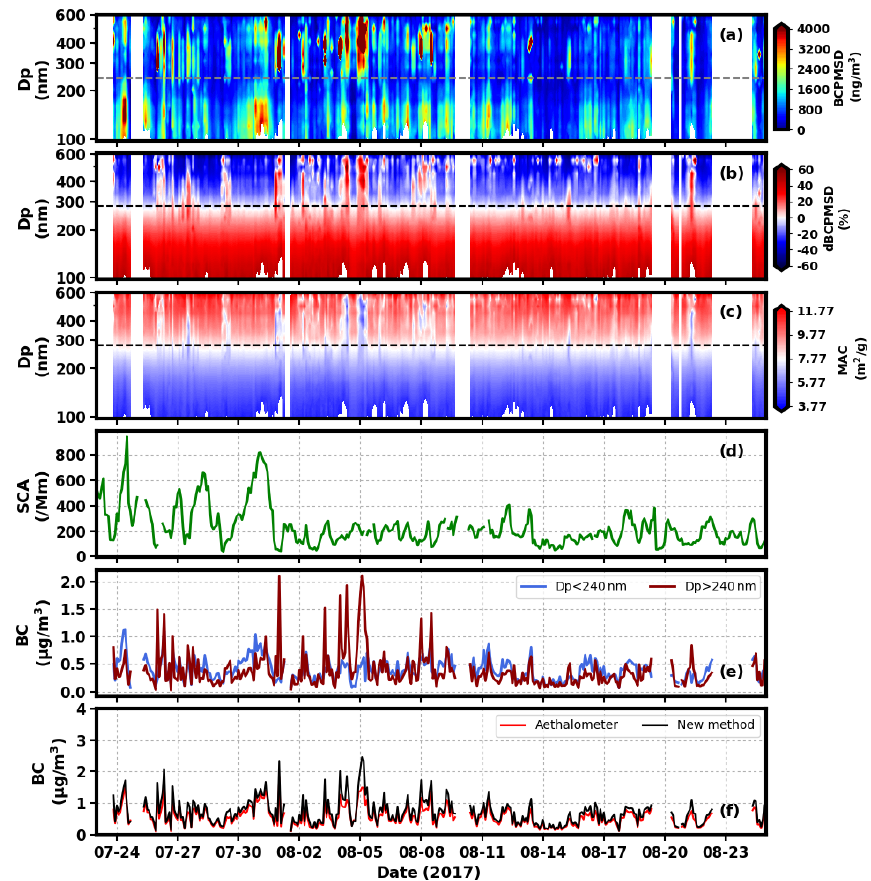
Figure 3. Time series of (a) the BCPMSD derived from the new method proposed in this work. The dashed line indicates the particle size of 240nm. (b) Relative deviations between the BCPMSD derived from the new method (varied MAC) and constant MAC at 7.77m 2 /g. The dashed line indicates the particle size of 280nm. (c) The size-resolved MAC. The dashed line indicates the particle size of 280nm. (d) The scattering coefficients at 525nm. (e) The EBC integrated for particles smaller than 220nm (blue) and larger than 220nm (red). (f) The EBC determined by the new method (black) and constant MAC of 7.77m 2 /g (red).